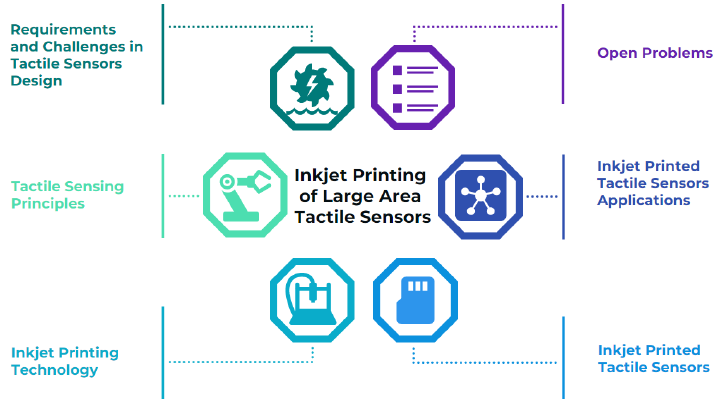
Figure 1. Map of all treated